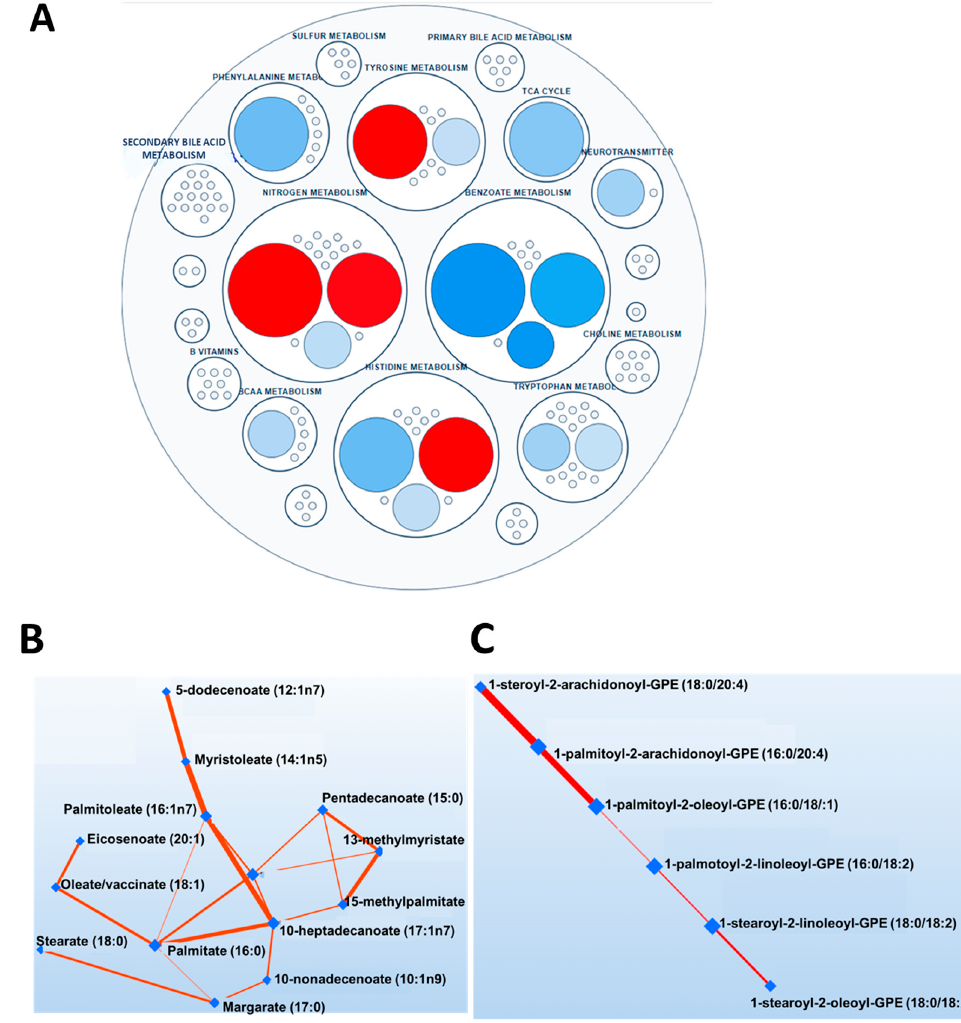
Figure 2. Top metabolic pathways in sex differences and a high-salt diet. ( A ) SmartPanel analysis shows significantly different pathways between men and women. ( B , C ) Pathway network analysis from a global metabolomic analysis identifying fatty acids as a top significantly changed pathway on a high Na + diet. Men ( n = 31) and women ( n = 44).